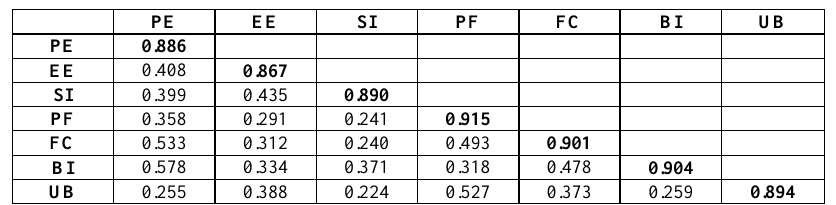
Table 4. Discriminant validity.